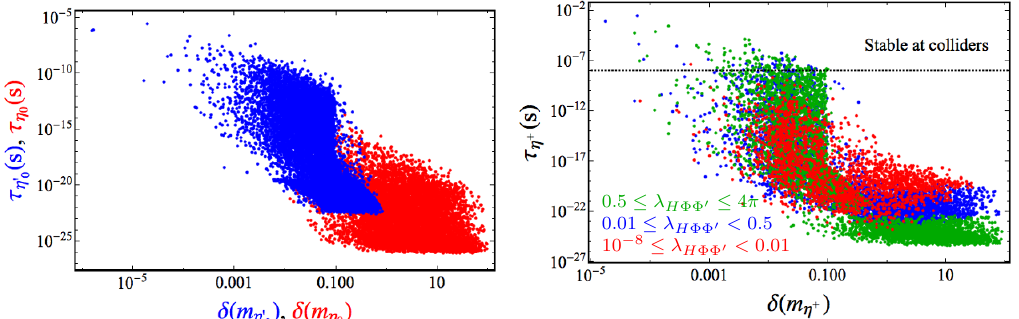
Figure 8 . Left panel: lifetime of the neutral scalars (cid:17) 0 (blue) and (cid:17) 0 (red) versus the normalised 0 mass splitting (cid:14) ( m x ) = ( m x m ) =m . Right panel: lifetime of the charged scalar (cid:17) + versus (cid:0) (cid:14) ( m (cid:17) + ) for di(cid:11)erent ranges of (cid:21) H (cid:8)(cid:8) 0 . We indicate with a horizontal dotted black line the minimum lifetime needed for the charged scalar to be long-lived at collider scales. A similar plot is obtained for the charged scalar (cid:17) 0 + .